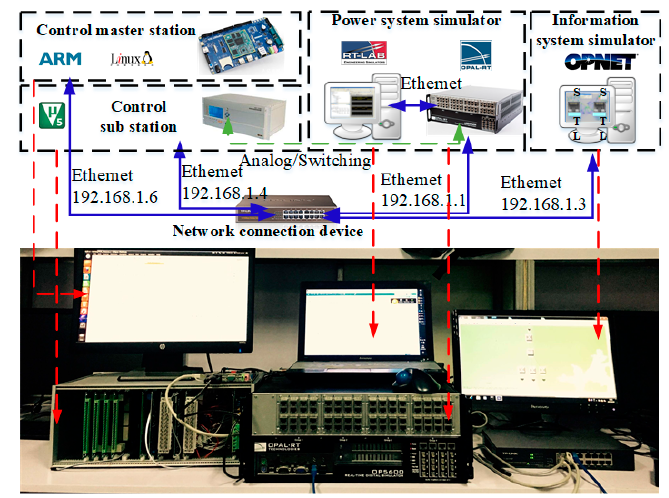
Figure 9. Framework of CPPS co-simulation platform.